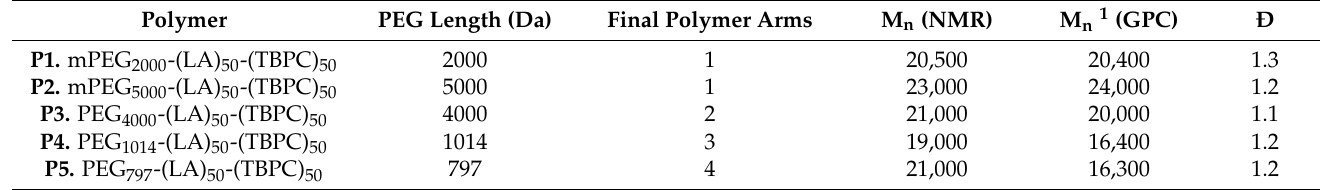
Table 1. Chemical characterisation of the PEGylated copolymers, nature of PEG blocks and number of polymer arms. Polymer PEG Length